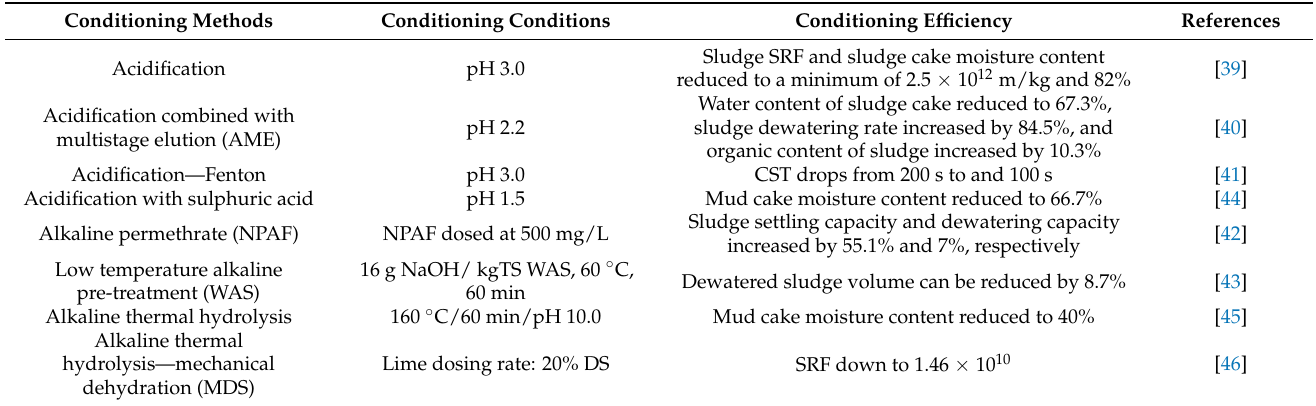
Table 5. Efficiency of different types of acid and alkaline conditioned